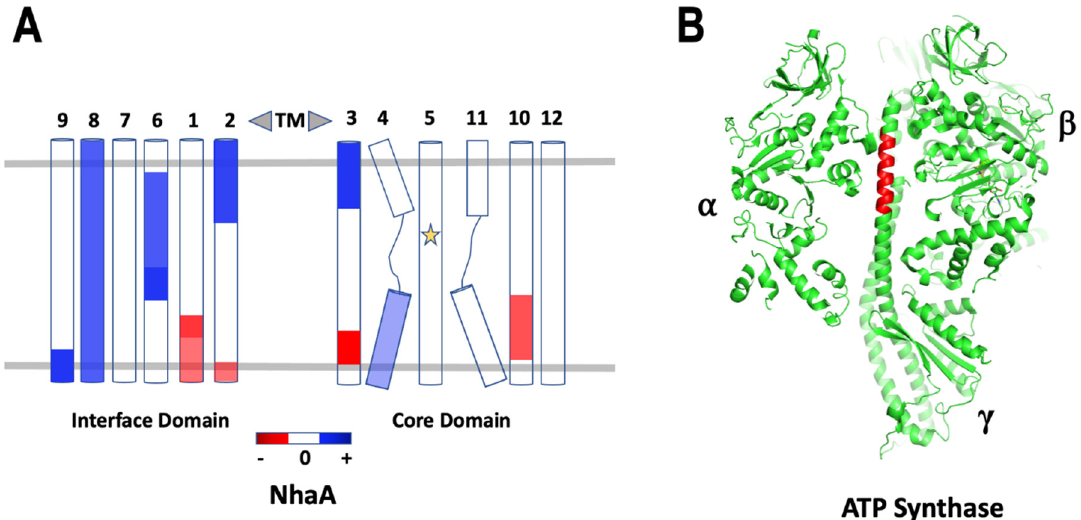
Figure 6. ( A ) Schematic showing the extent of deuterium exchange using a color gradient from red (decreased)—white (unchanged)—blue (increased) in the TMs of NhaA. The yellow star denotes the binding site for Li + . ( B ) The structure of F 0 F 1 -ATP synthase (PDB 3OAA) highlights the C-terminal helix in the γ subunit which shows maximum exchange.